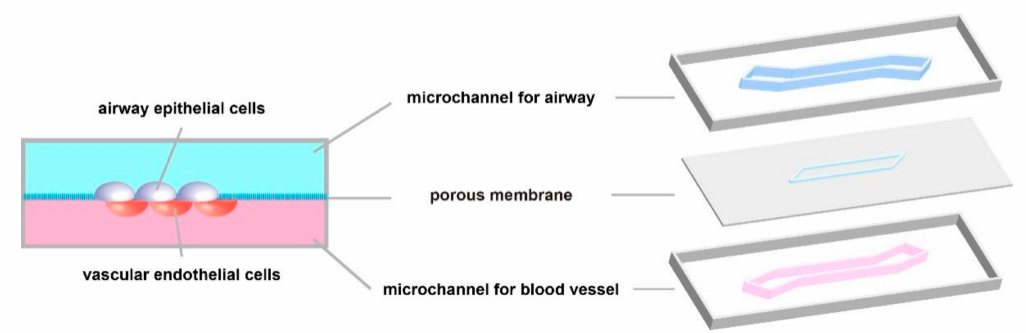
Figure 3. Common dual-channel model of cell co-culture. The upper channel is exposed to the air for culturing epithelial cells; the culture fluid flows in the lower channel for culturing vascular endothelial